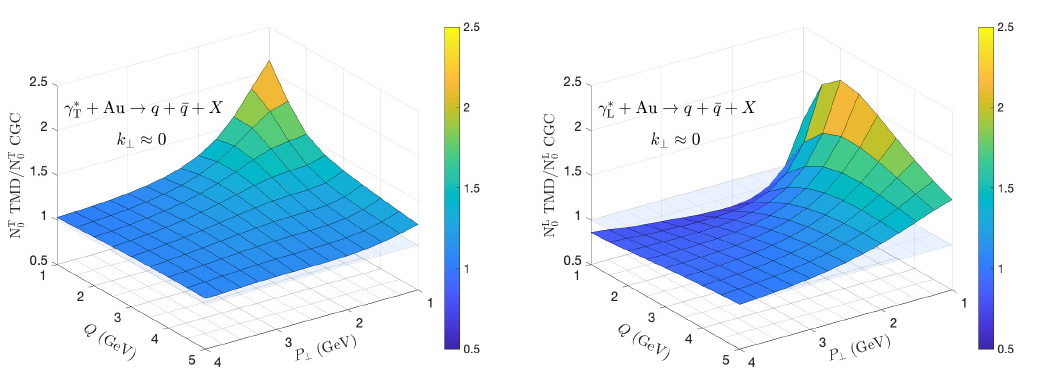
Figure 7 . Ratio of TMD to CGC for near back-to-back kinematics k ⊥ ≈ 0 in γ ∗ as a function of virtuality Q and relative momentum P ⊥ . Left: transversely polarized case. Right: longitudinally polarized